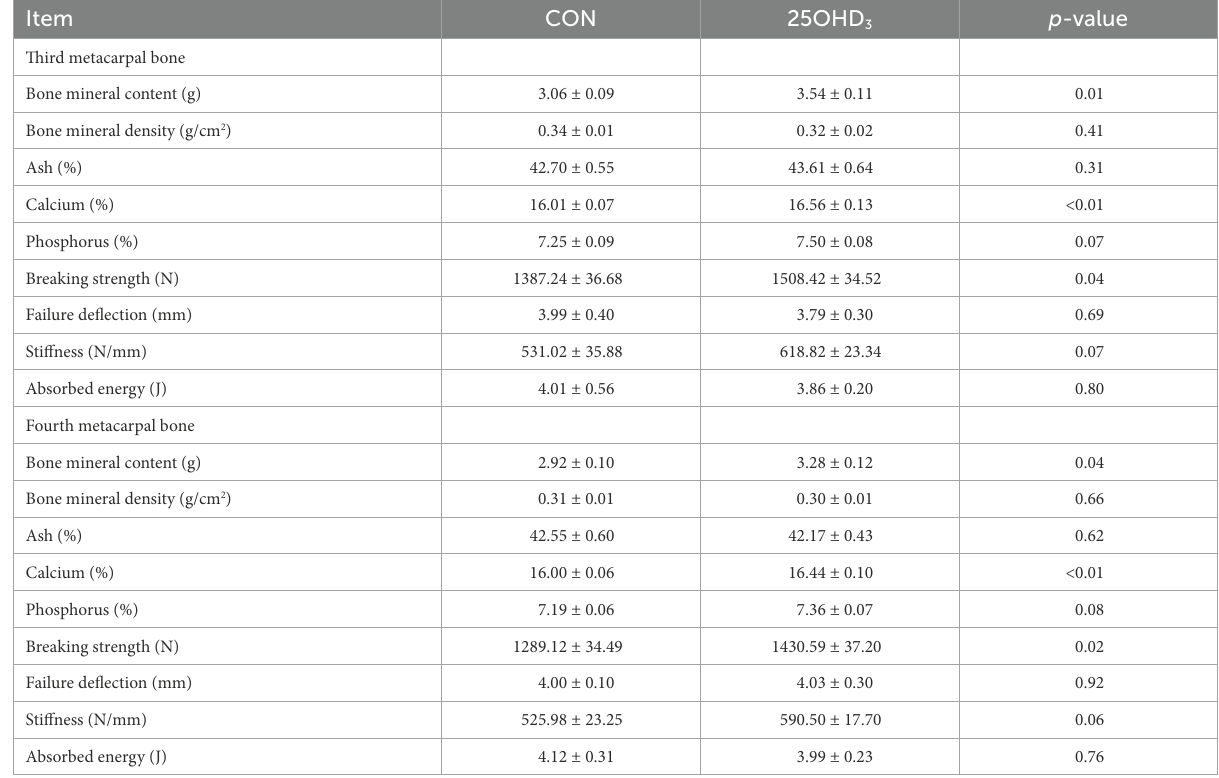
TABLE 7 Effects of 25OHD 3 supplementation on bone property in the metacarpal bones of growing-finishing pigs. Item CON 25OHD